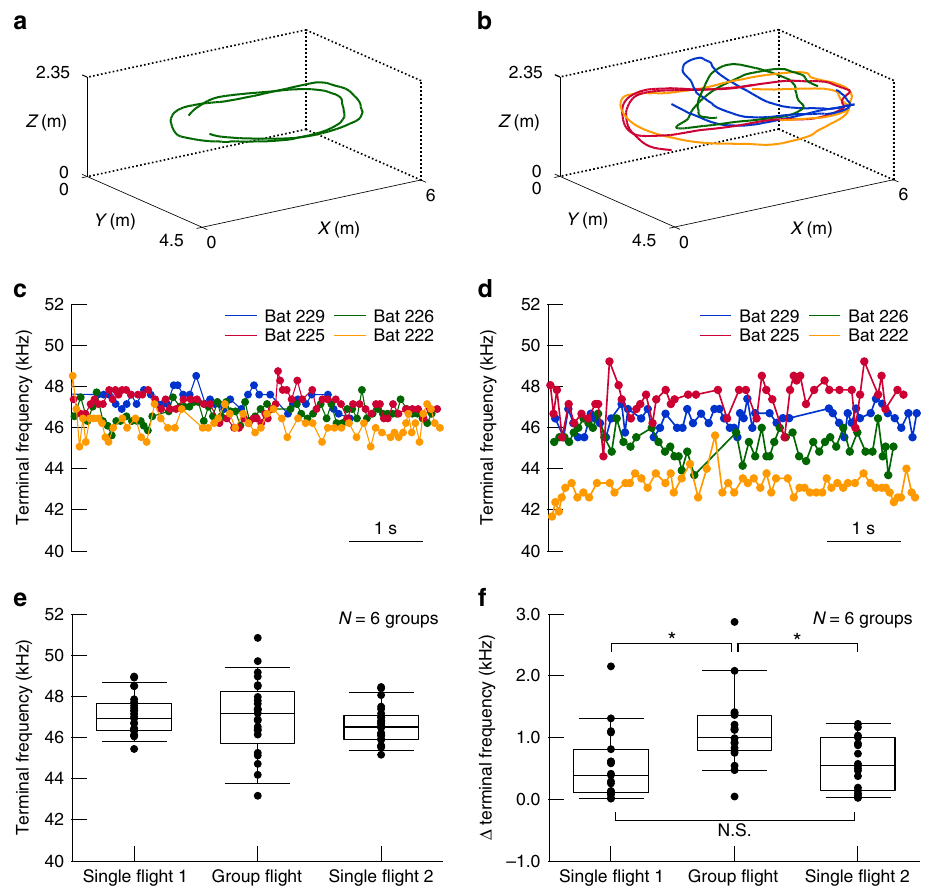
Fig. 2 Echolocating bats use different terminal frequency channels during group fl ight. a , b Flight trajectories of a bat during single fl ight 1 and four bats during group fl ight for group 1. c , d Changes in the terminal frequencies of pulses emitted by four bats during single fl ight 1 and group fl ight. e , f Changes in acoustic characteristics of pulses emitted by bats during single fl ight 1, single fl ight 2, and group fl ight. The horizontal lines inside the boxes show the medians. The upper and lower bounds of the boxes show fi rst and third quartile, respectively. The horizontal bars above and below the boxes show the 10th and 90th percentiles, respectively. e Mean terminal frequencies of each bat of all six groups in single fl ights 1, 2, and group fl ight. The data were collected from six groups (19 bats), and we obtained 24 data points per fl ight condition. f Δ terminal frequencies of all six groups in single fl ight 1, single fl ight 2, and group fl ight. We collected three Δ terminal frequencies per group, which yielded 18 data points per fl ight condition. The mean terminal frequency did not differ among fl ight conditions (one-way ANOVA, P = 0.365). Δ terminal frequencies were signi fi cantly increased in group fl ight compared with single fl ights 1 and 2 (Tukey ’ s HSD test, P <